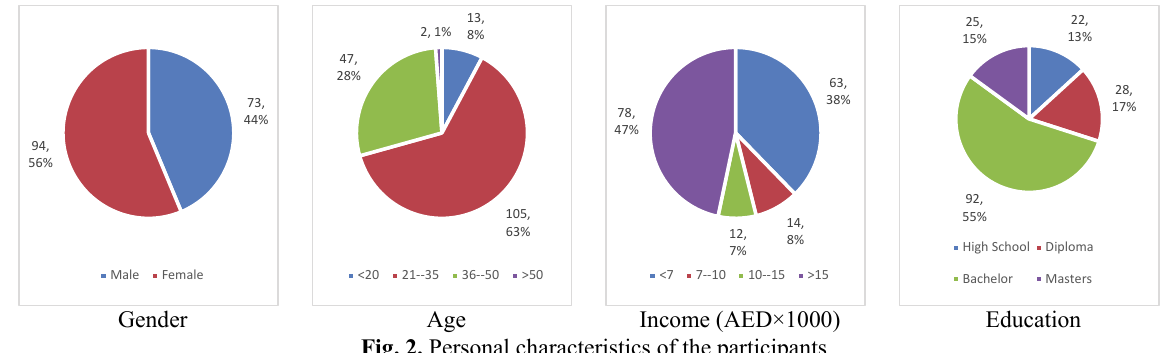
Fig. 2. Personal characteristics of the participants